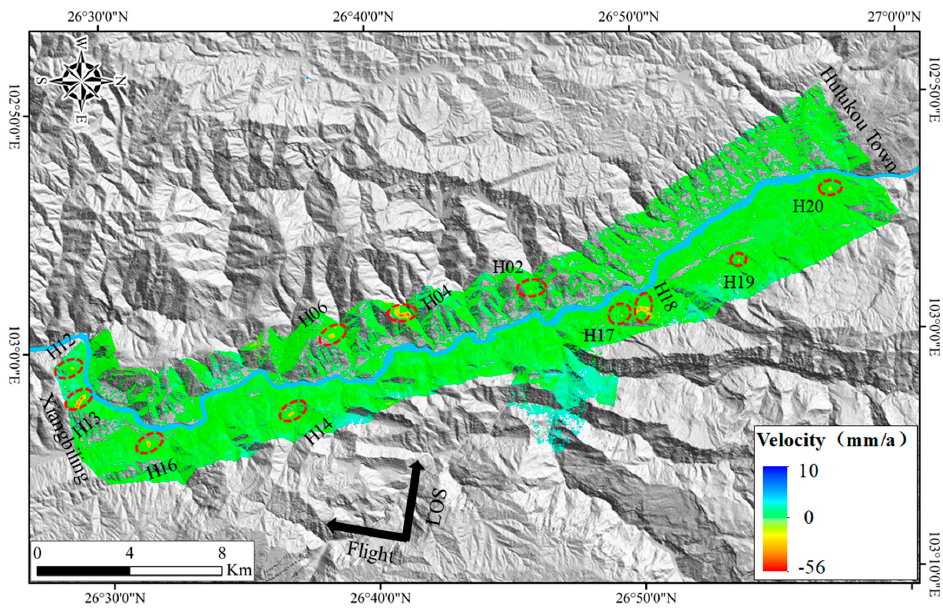
Figure 15. Effective deformation results of Sentinel-1A ascending data in the study area.